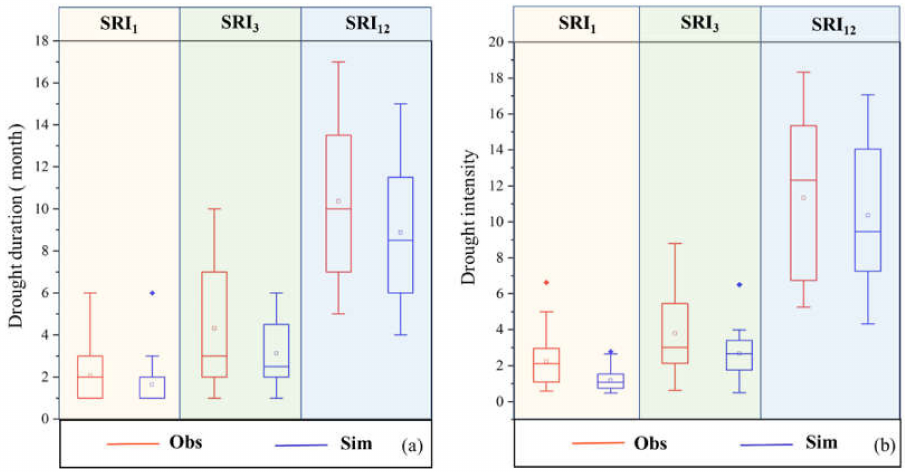
Figure 8. Boxplots of drought duration and drought intensity based on the observed and simulated runoff during the impact period. ( a ) Drought duration; ( b ) drought